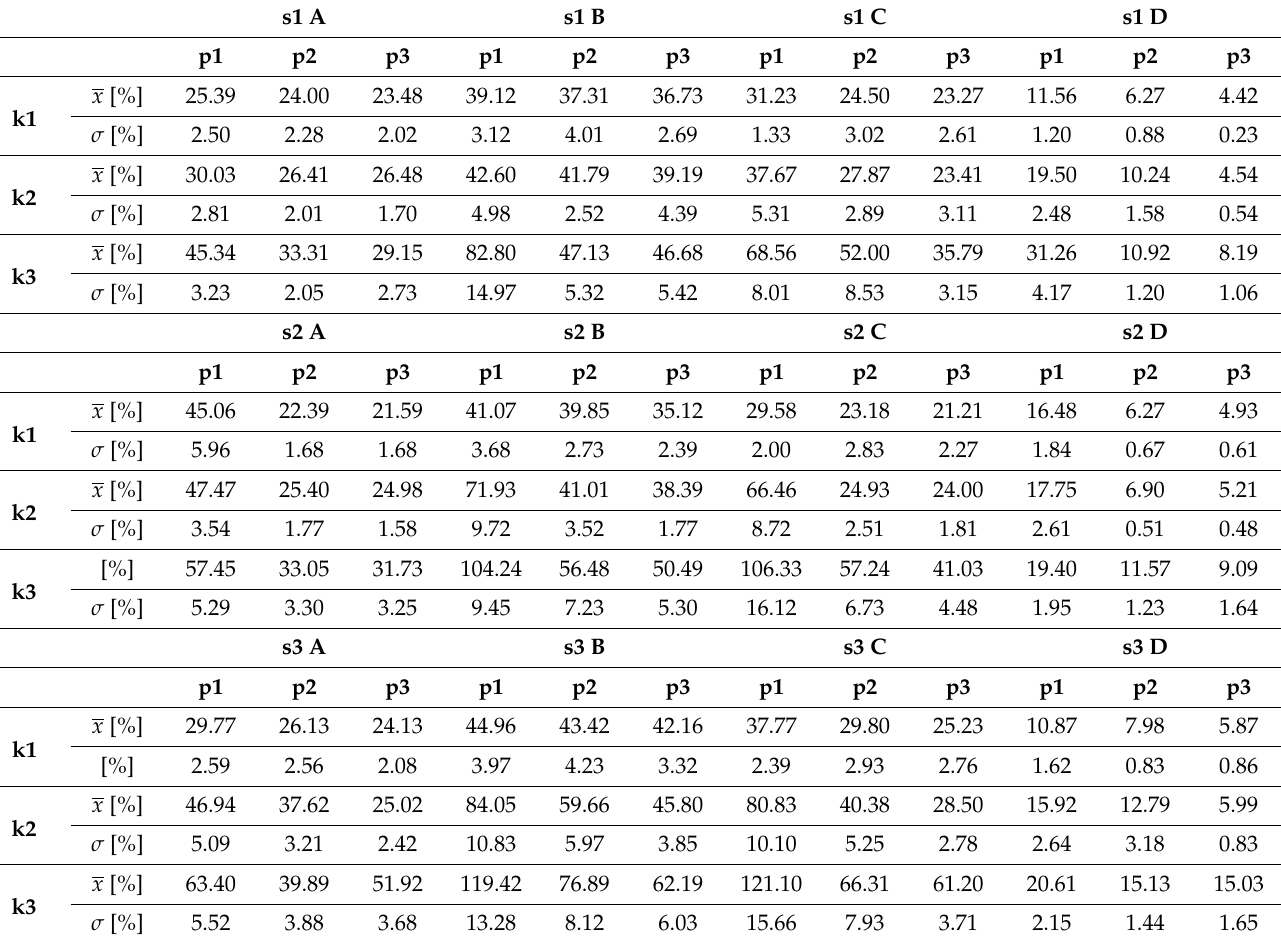
Table 4. The average values and the statistical data on the average amplitude of the EMG signal values ( MVC MAX ) for the individual propulsion cycles; x —the arithmetic mean, σ —the standard deviation of the arithmetic mean; the muscle markings: Deltoid muscle anterior (A) and posterior (B), Triceps brachii (C), Extensor carpi radialis longus (D); markings of experiment series: s1, s2 and s3; markings of the propulsion system gear ratios: p1 = 1.96, p2 = 1 and p3 = 0.51. s1 A s1 B s1 C s1